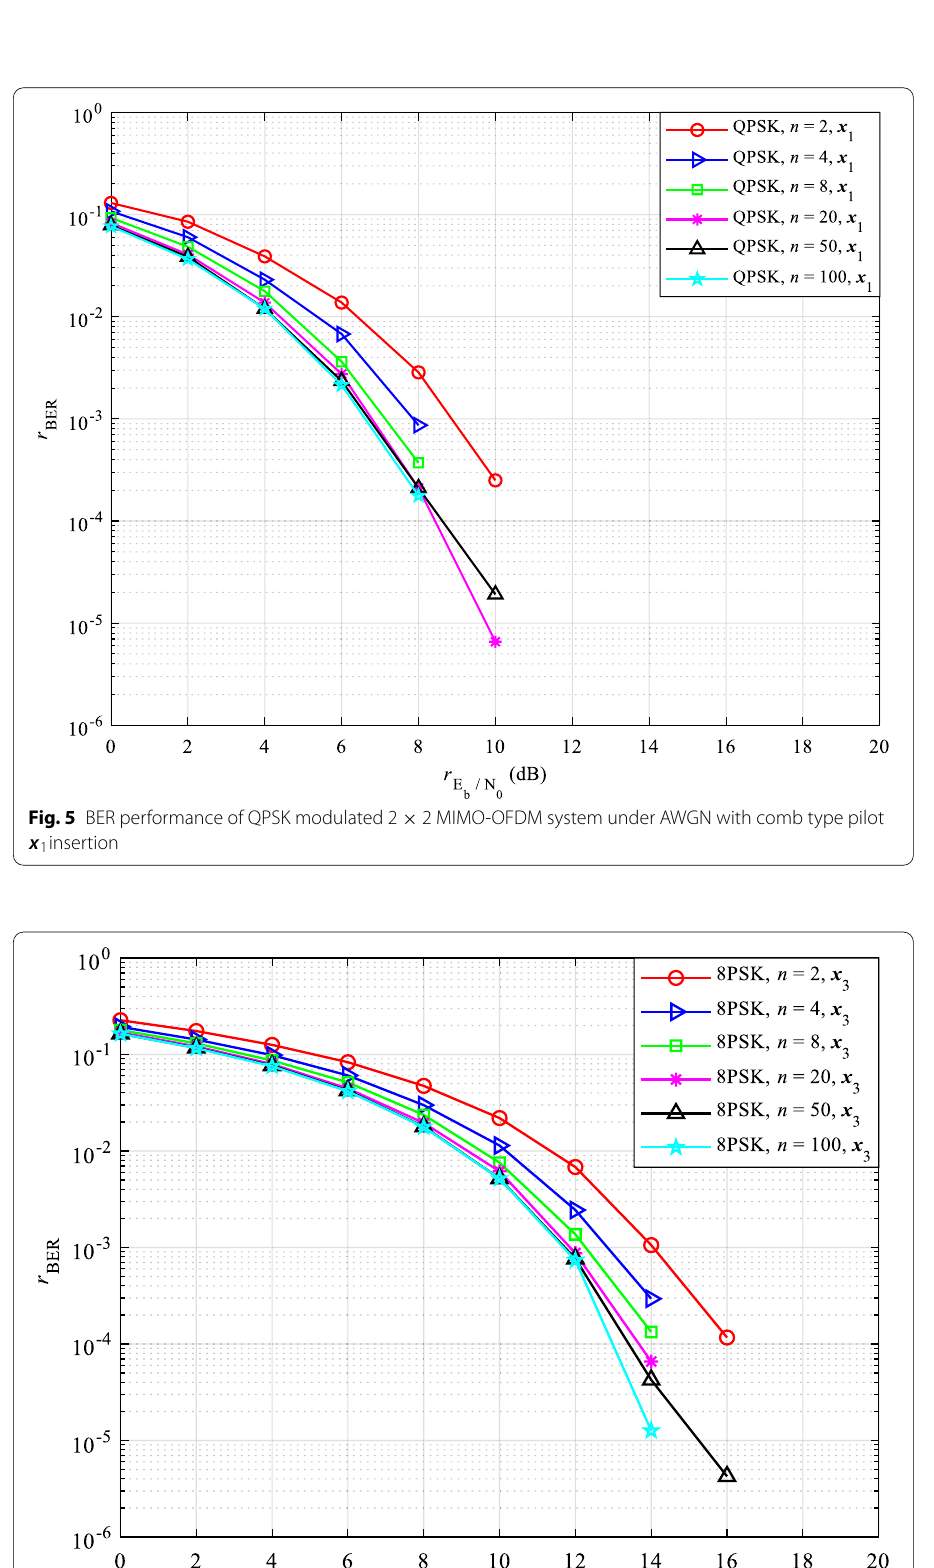
2 MIMO-OFDM system under AWGN with comb type pilot ×